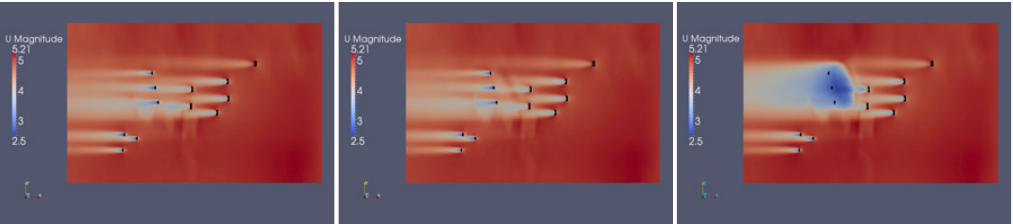
Figure 3. Magnitude of the wind speed (in ms − 1 ) at a height of 65m for case A (left), B (center) and C (right). Incoming wind from the East